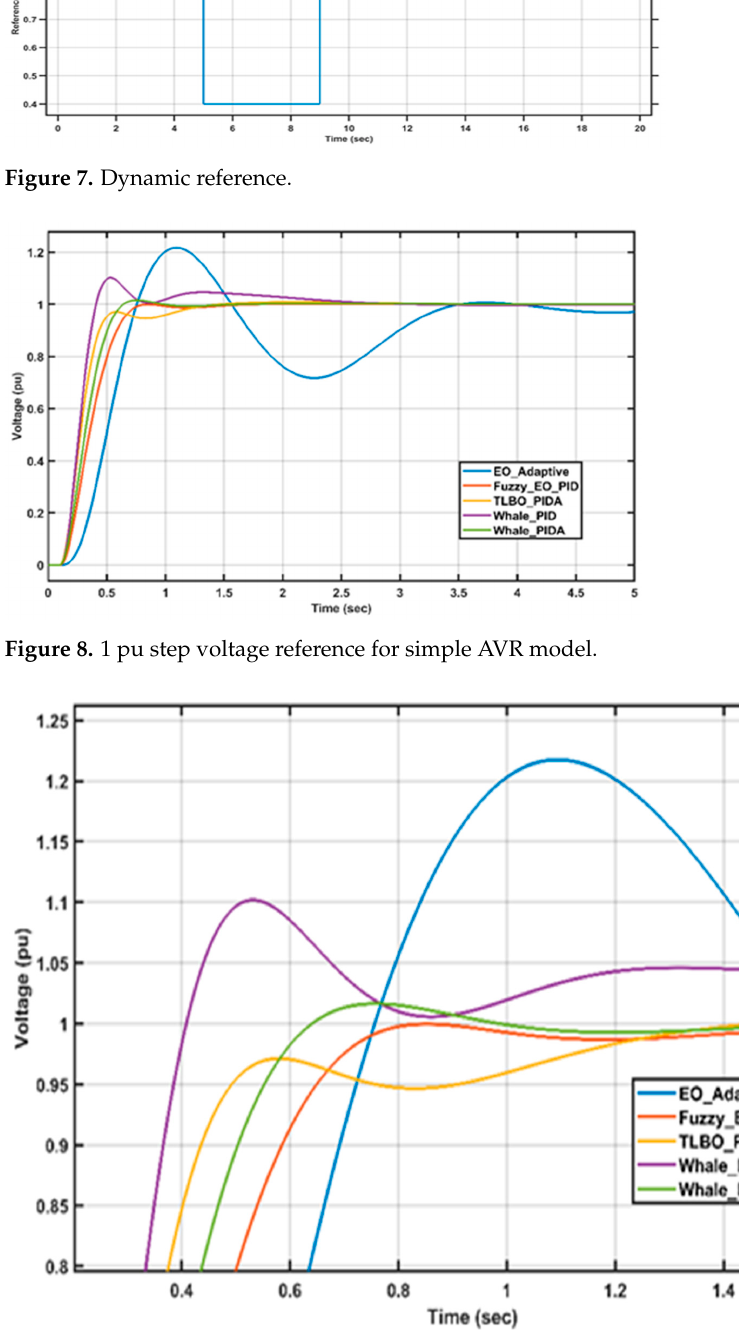
Figure 10. 0.8 pu step voltage reference for simple AVR model.